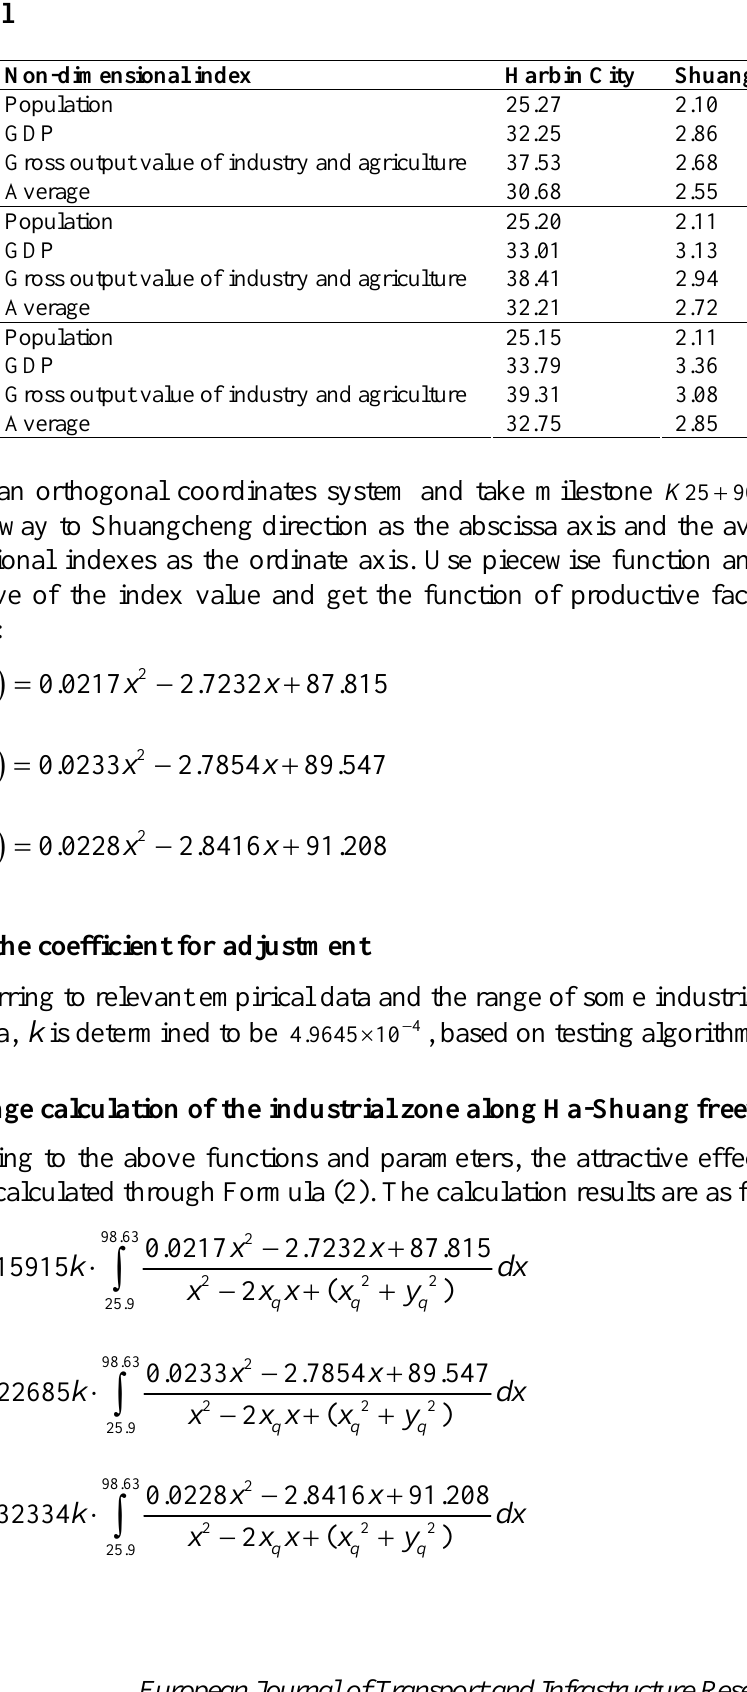
Table 4. The value of metrical indexes for productive factors after non-dimensional